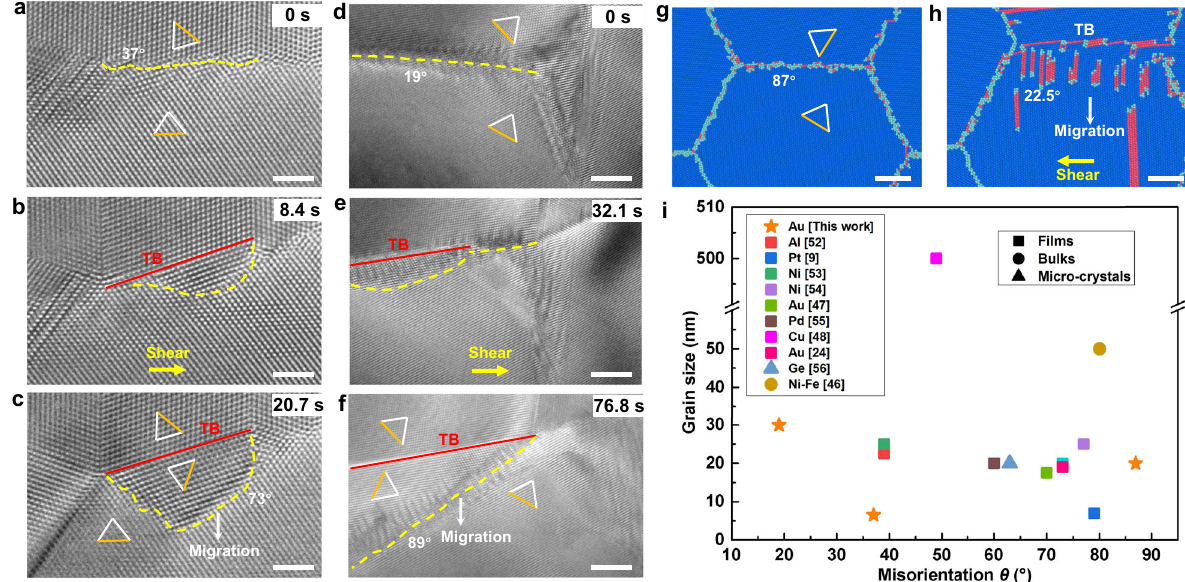
Fig. 5 Twinning-assisted GB dynamics in nanocrystalline metals. a – c Self-driven adjustment of a HAGB. a A 37° HAGB in nanocrystalline Au fi lm pinned by two GB junctions. b TB nucleation accompanied with GB rotation under shear loading. c Complete transformation of the GB. d – f Self-driven adjustment of a LAGB. d A 19° LAGB in nanocrystalline Au fi lm with one end pinned by a triple junction. e GB structural transformation assisted by deformation twinning. f Migration of the newly formed 89° GB. g and h MD simulation snapshots of deformation dynamics of an 87° HAGB in a nanocrystalline Au sample, which was transformed to a 22.5° GB by GB dissociation induced twinning. i Summary of GB-associated deformation twinning in a wide range of FCC metallic